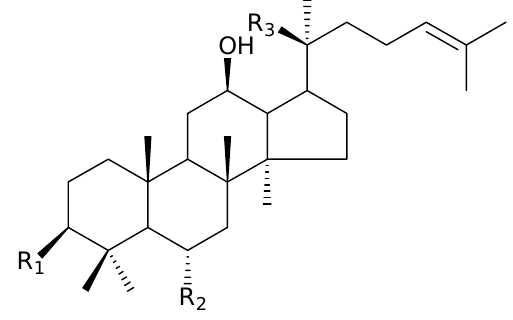
Figure 1. Isolated, enzyme produced and synthetic ginsenosides.